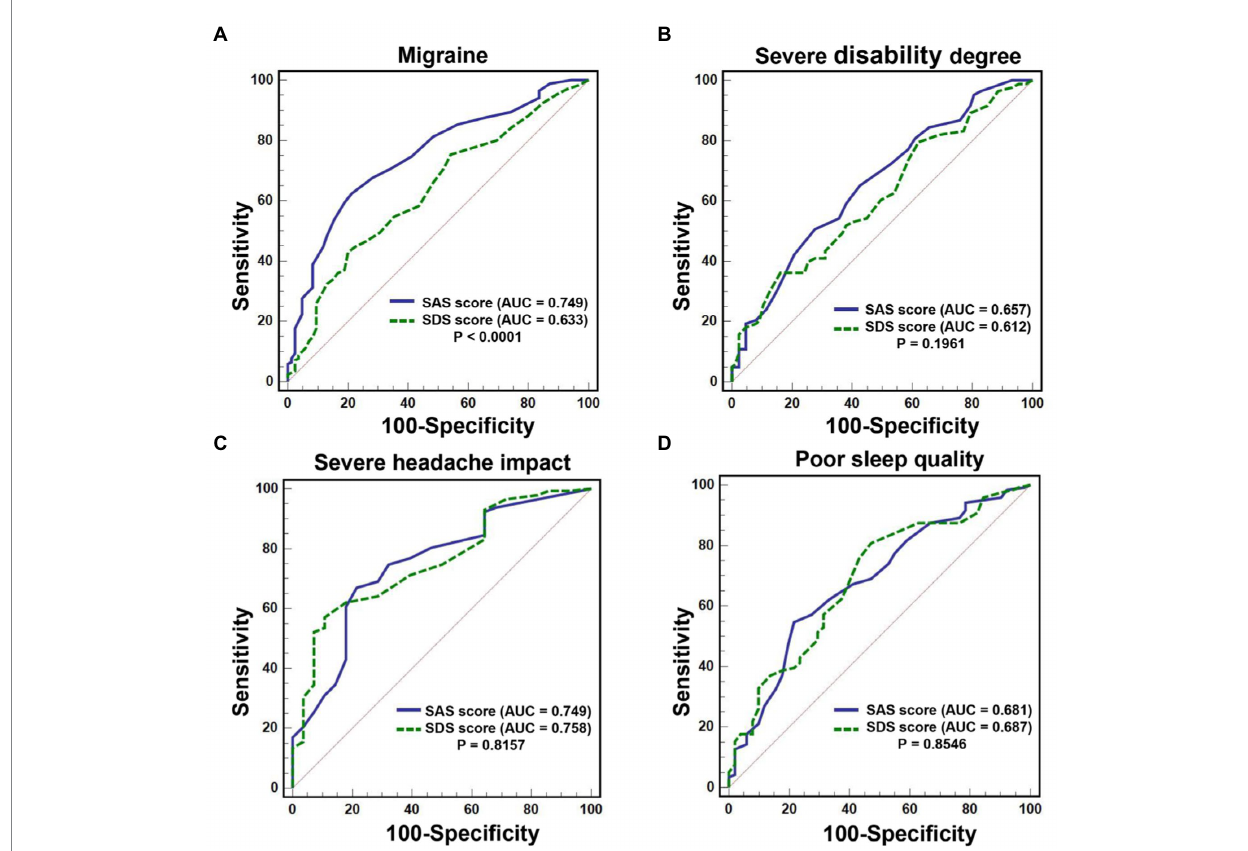
FIGURE 3 ROC curve of SAS score and SDS score in predicting migraine and the severe burden of migraine. (A) : The AUC of SAS score in predicting developing migraine was significantly higher than that of SDS score [0.749 (95%CI: 0.691–0.801) vs. 0.633 (95%CI: 0.571–0.692), p < 0.0001]. (B–D) : There was no significant difference in the AUC between SAS score and SDS score for predicting poor sleep quality, severe disability degree, and severe headache impact in migraine patients (all p >